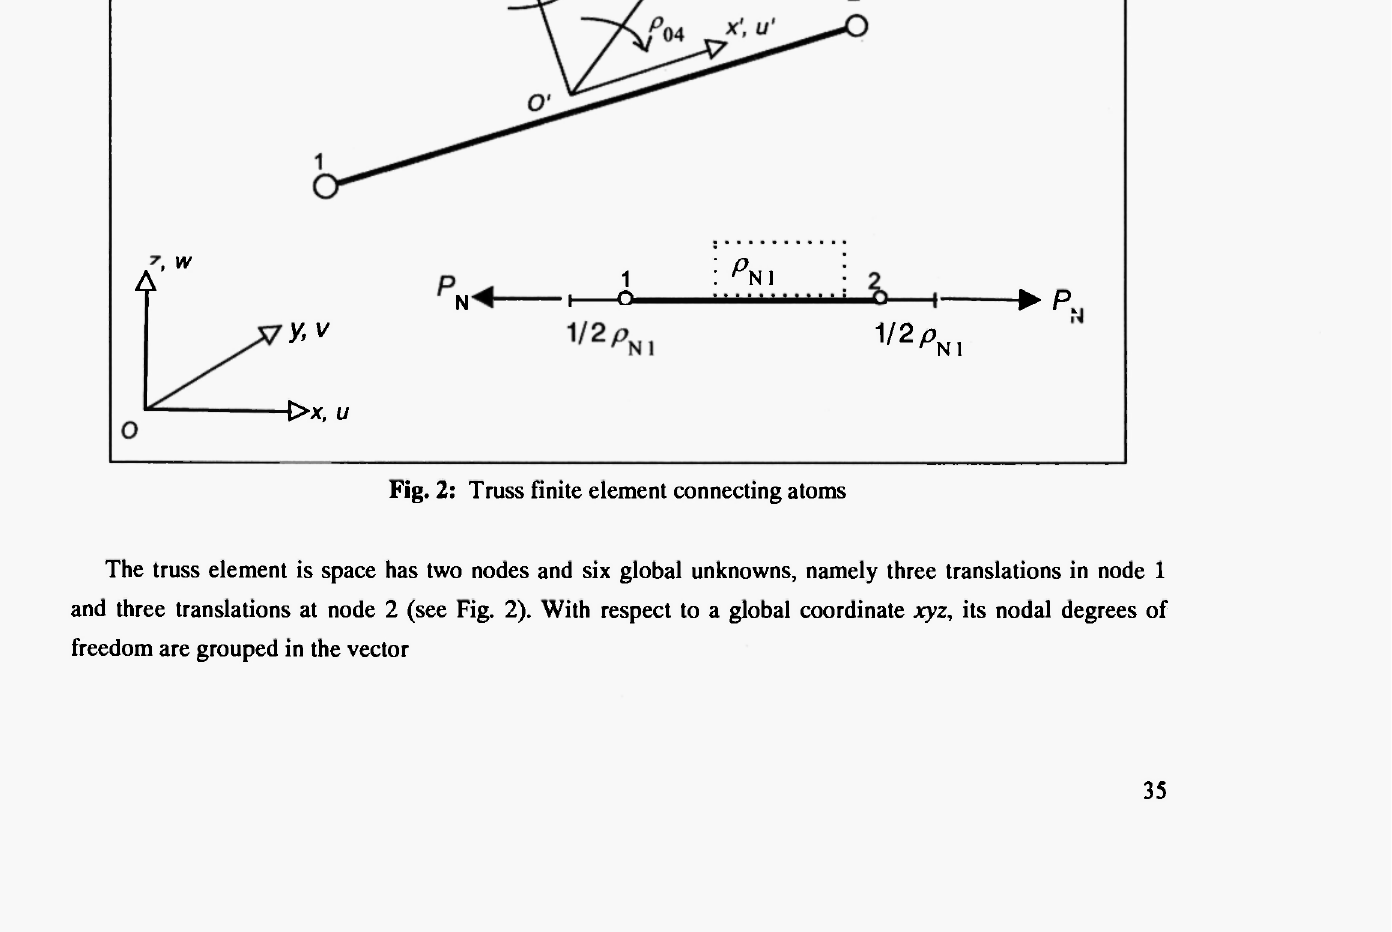
Fig. 1: Continuum modelization; forces between atoms